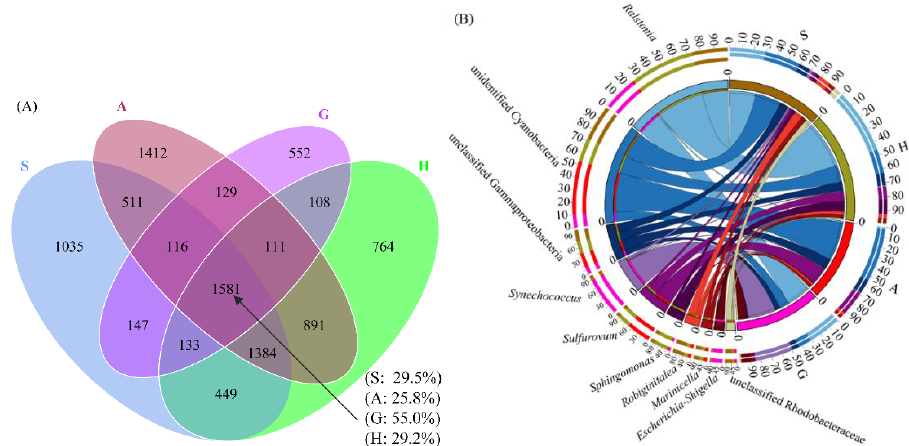
Figure 6. ( A ) Venn diagram of OTU composition in the worm intestine and different sediments. The percentages in brackets of the Venn diagram indicate the ratios of the number of shared OTUs to the total number of OTUs in each group. ( B ) Circos diagram of the top 10 microbial genera based on shared OTU analysis for the intestine and sediment samples. The width of the bar of each genus indicates the relative abundance of that genus in the sample. The central circle shows connections between microbial genera and the samples in which they occur. S — surface sediment; H — sediment in the hole; A — ambient sediment; G — gut of S. nudus .